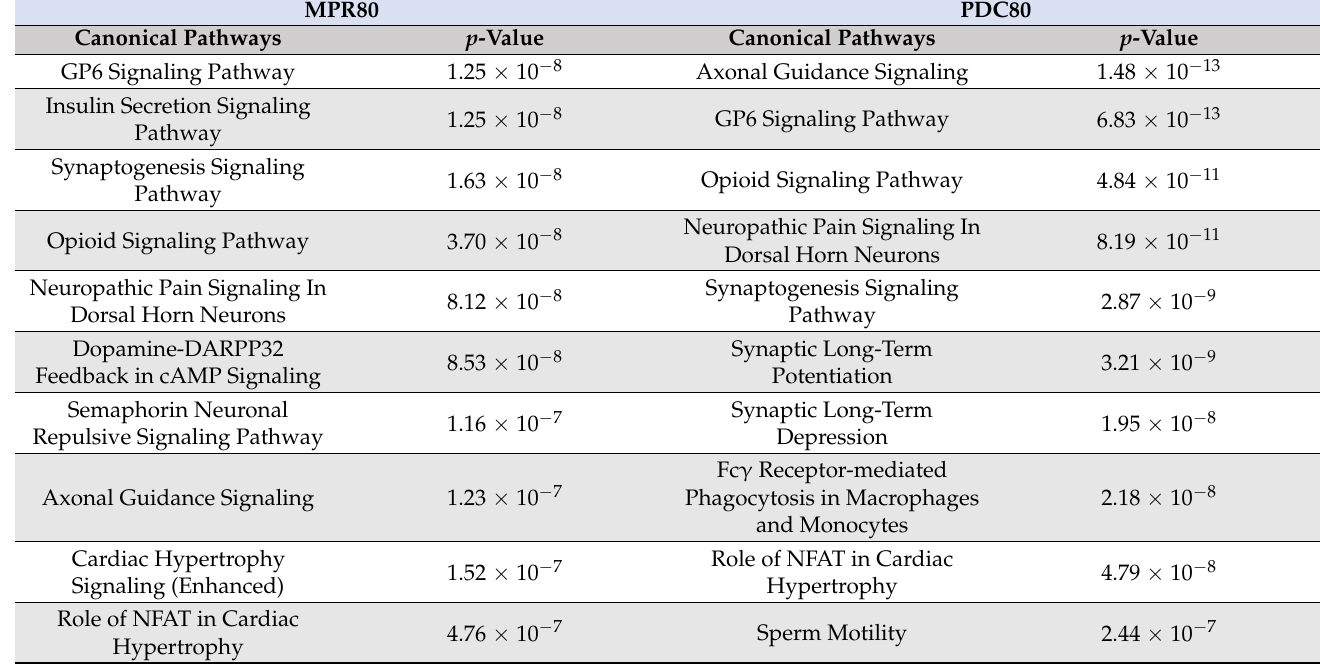
Table 5. Top ten statistically significant ( p < 0.05) canonical pathways affected by genes identified by IPA analysis for each non-adherence measure. MPR80